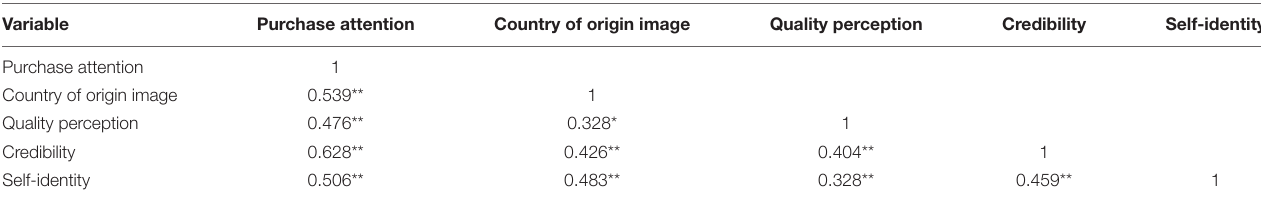
TABLE 3 | Correlation statistical analysis.